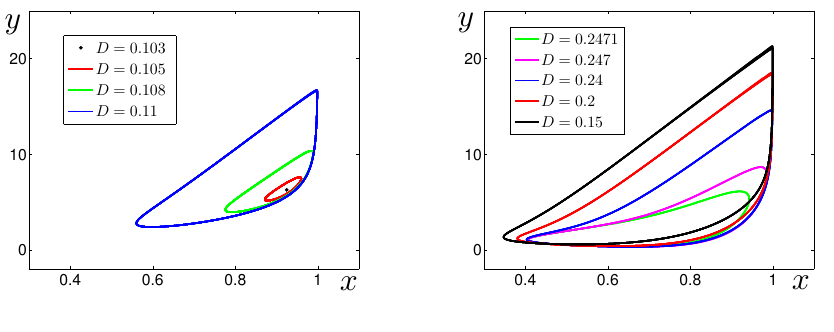
Figure 3. Limit cycles of the system